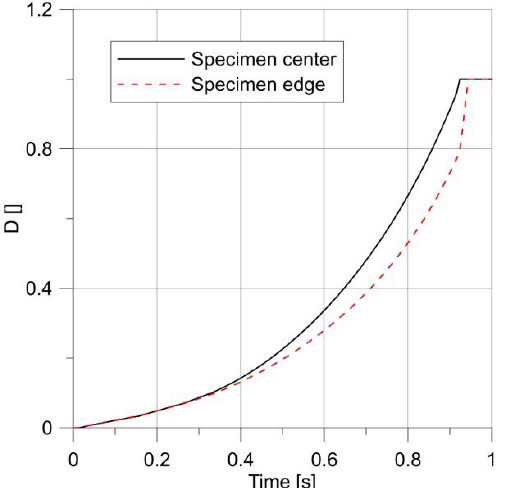
Figure 10. Changes in the D parameter over time for a smooth round specimen.